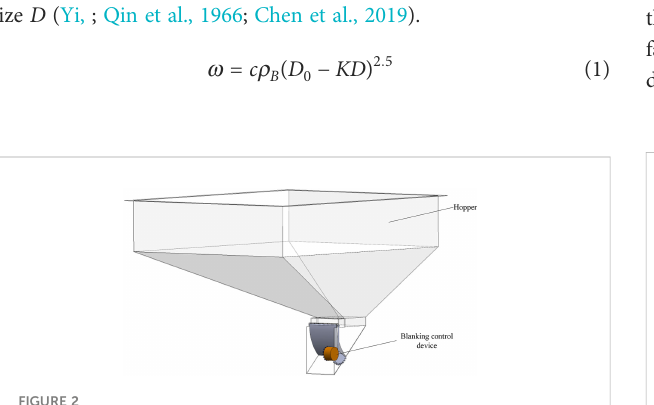
FIGURE 2 Hopper and blanking control device.